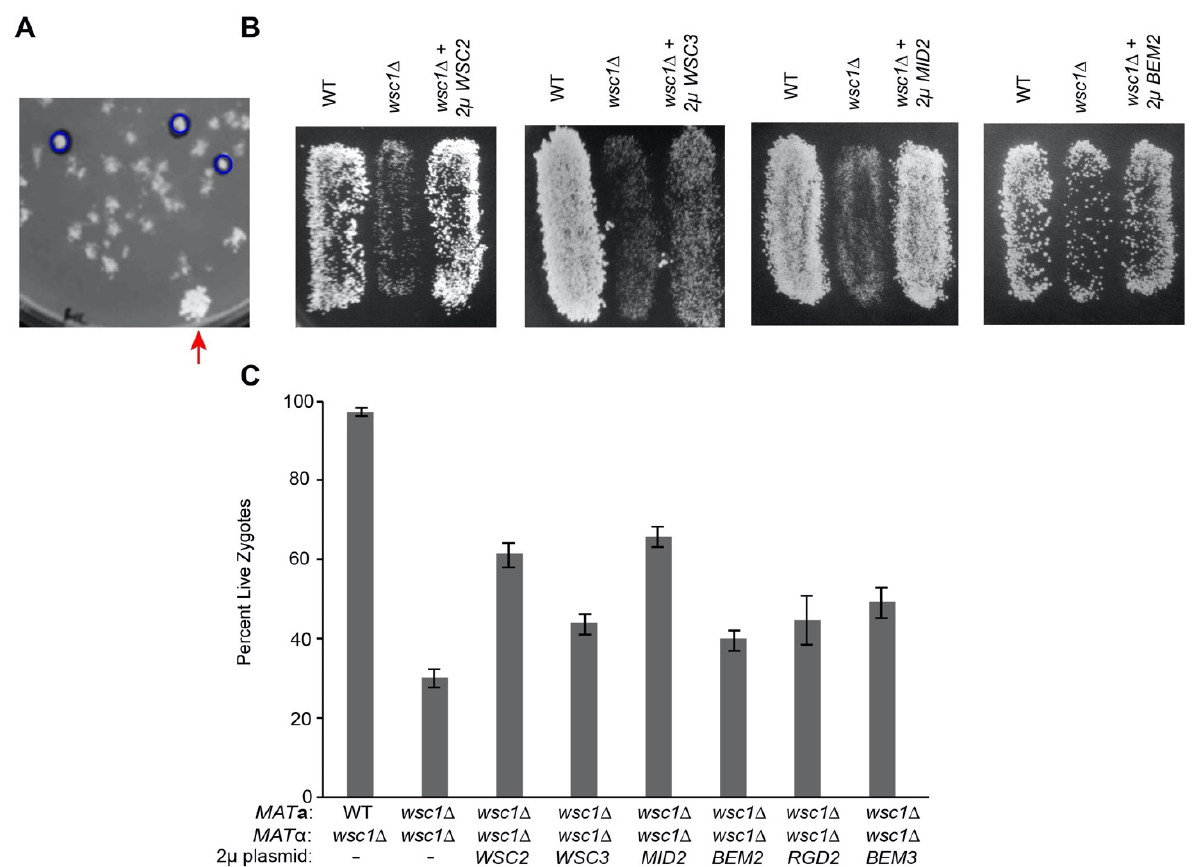
Figure 4. Overexpression of components of the CWI pathway suppress wsc1 ∆ death. ( A ) Example mating plate. A small patch of wild type (MY8093) cells were placed on the mating plate as a control (red arrow). Robust colonies, circled in blue, were picked for retesting. This image is of an 8.5 cm petri dish, the panel is 4.7 cm in width. ( B ) Overexpression suppression of wsc1 ∆ . Mating of WSC2 , WSC3 , MID2 , and BEM2 overexpression in a wsc1 ∆ background. Patches of MAT α WT (MY8093) and wsc1 ∆ (MY14306) strains transformed with an empty 2 μ vector (pRS425) along with wsc1 ∆ transformed with 2 µ WSC2 (MY15816), 2 µ WSC3 (MY15817), 2 µ MID2 (MR6979) were mated to a MAT a wsc1 ∆ lawn. For BEM2 overexpression WT (MY8093) and wsc1 ∆ (MY14306) were transformed with empty vector (pRS426) or 2 μ BEM2 (MR6988) and mated as above. Matings were incubated for 3 h at 30 °C and then replica plated onto diploid selective media. In each case the images are of patches of cells growing on 8.5 cm petri dishes; the image panels are 4.0 cm in width. ( C ) Overexpression of potential CWI pathway regulators suppresses wsc1 ∆ x wsc1 ∆ zygote death. WT (MY8092) and wsc1 ∆ (MY14306) were transformed with an empty 2 μ vector (pRS425) or wsc1 ∆ was transformed with 2 μ WSC2 (MY15816), WSC3 (MY15817), MID2 (MR6979), or BEM2 (pMR6988). Each MAT α was mated to MAT a wsc1 ∆ (MY14305) for 3 h at 30 °C, resuspended in TAF buffer and imaged with FM4-64. n ≥ 100 zygotes for each mating. Error bars represent the standard error. Chi-squared statistical tests were used to calculate significance.